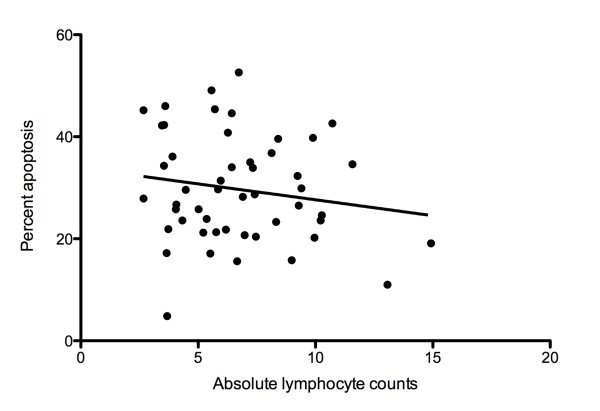
Absolute lymphocyte counts did not correlate with peripheral lymphocyte apoptosis in RA patients. Correlation co-efficient r = -0.08956; p value = 0.5362; Pearson r correlation.